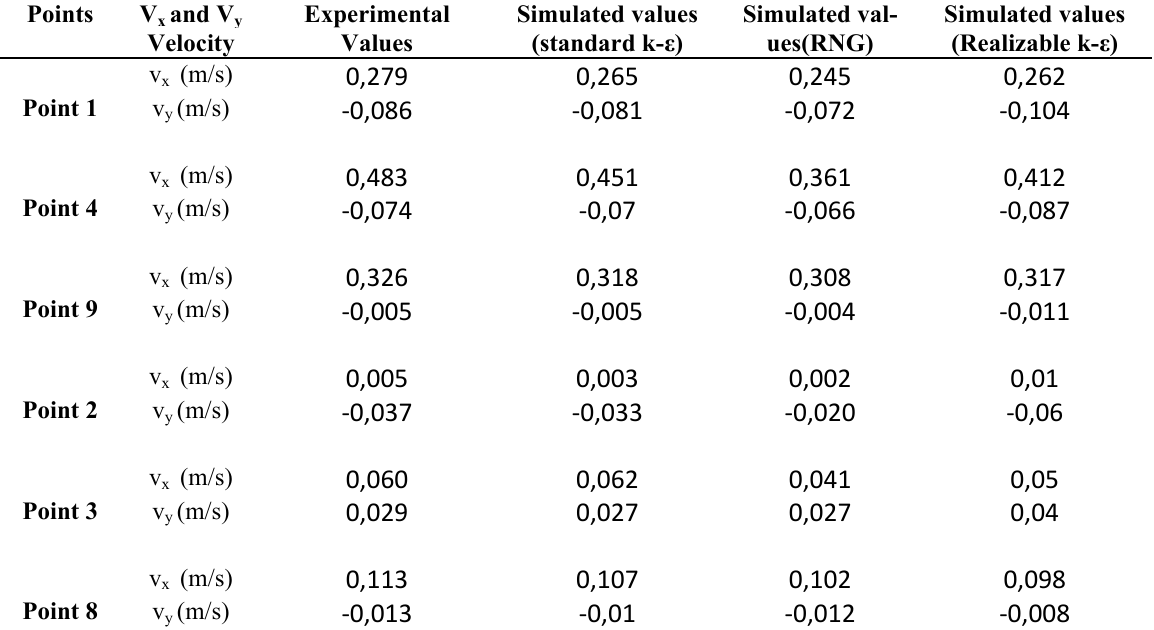
Table 5. The measured and simulated values of the velocity